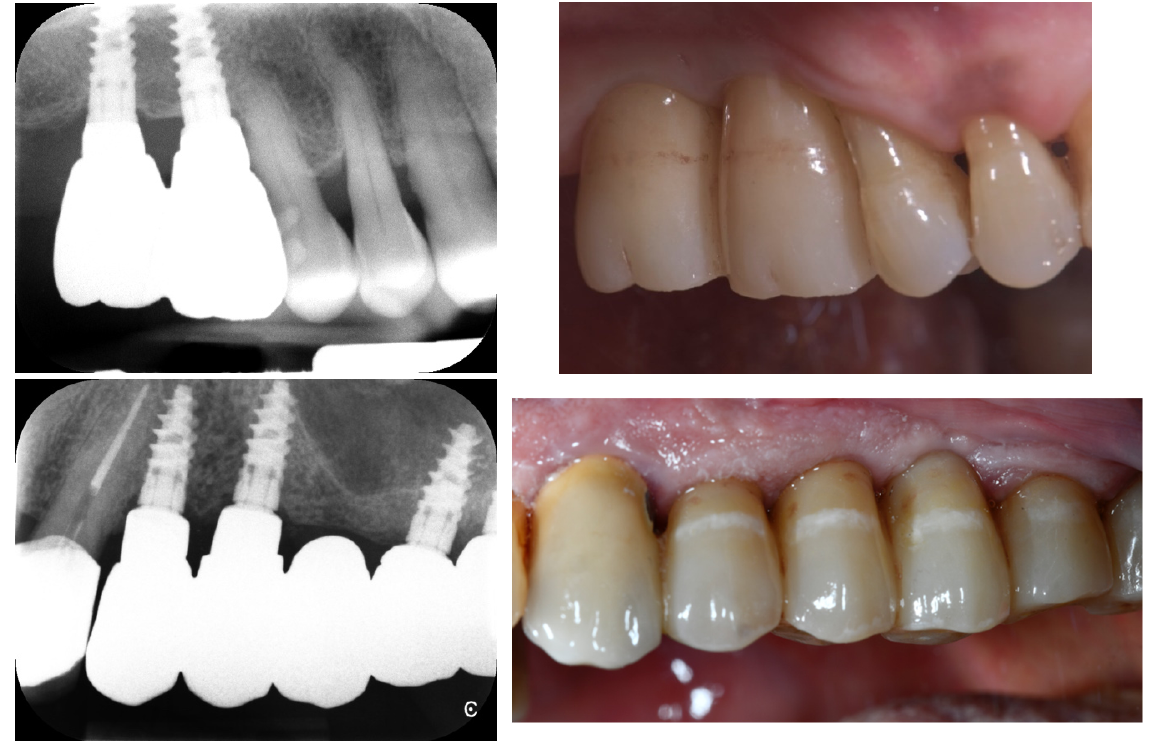
Figure 1. Clinical and radiographic images of CS and IH implants at the three-year follow-up. At the three-year follow-up visit, 30 patients (14 males, 16 females, mean age: 69.4 y ± 12.6) with 64 implants (32 CS and 32 IH) were examined, and demographic data are reported in Table 1. Demographic data of patients analysed at the three-year follow-up